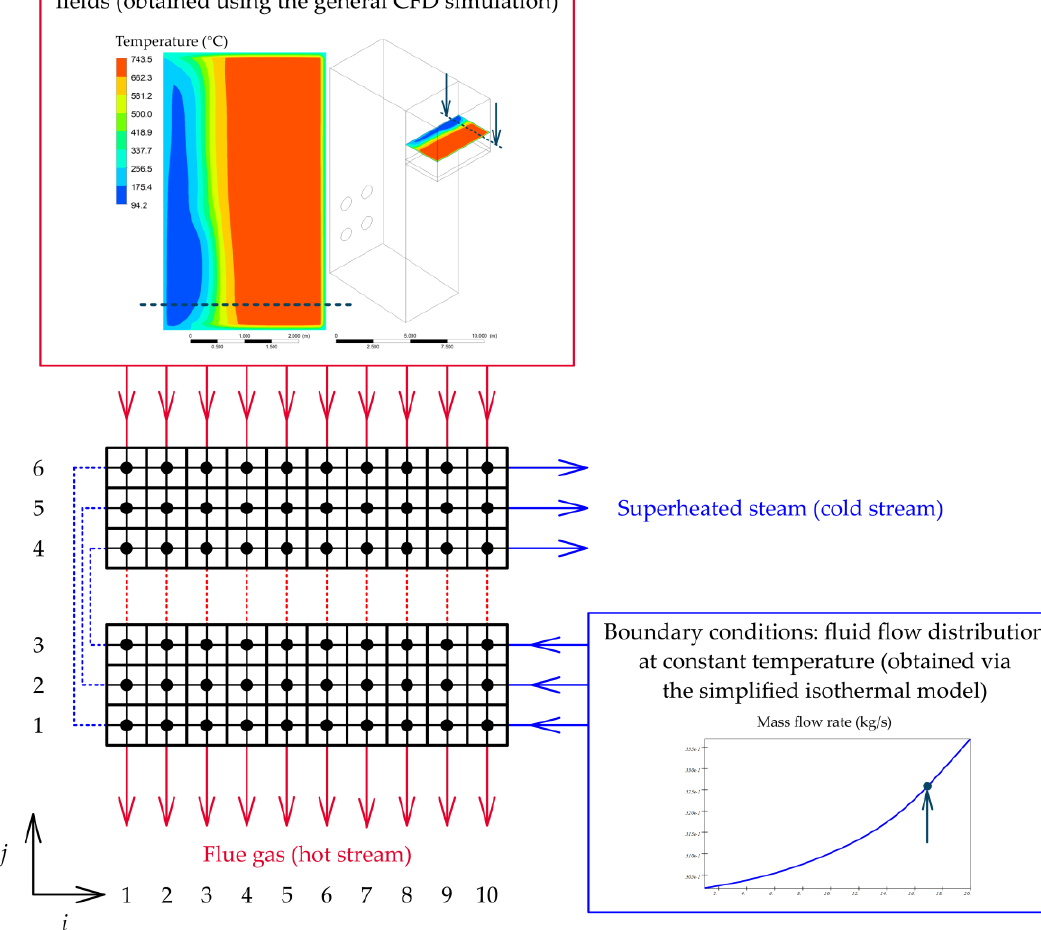
Figure 9. Concept of the heat and fluid flow distribution modelling system illustrated on two passes of the heat exchanger in question. Flow data of the flue gas are provided by the previous general CFD analysis [19] while distribution of steam was pre-solved using a simplified model based on Bailey’s approach [25].